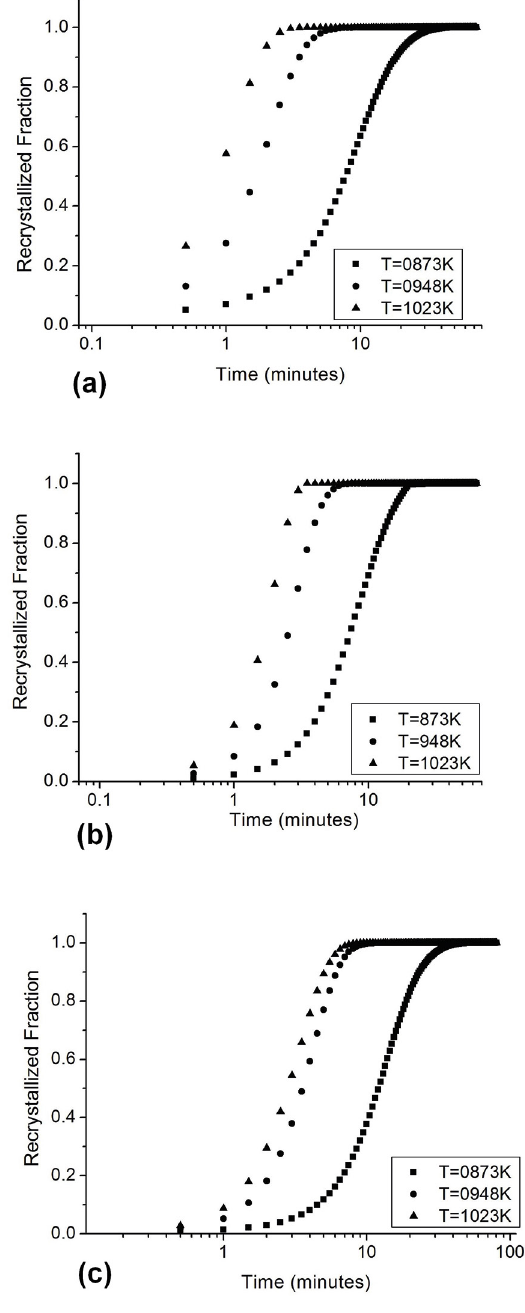
Figure 1: Graphs of the recrystallized fractions as a function of time at temperatures of 873 K, 948 K and 1023 K, and nucleation mechanisms corresponding to site saturation (a), constant rate (independent of annealing temperature) (b), and treatment temperature- dependent rate